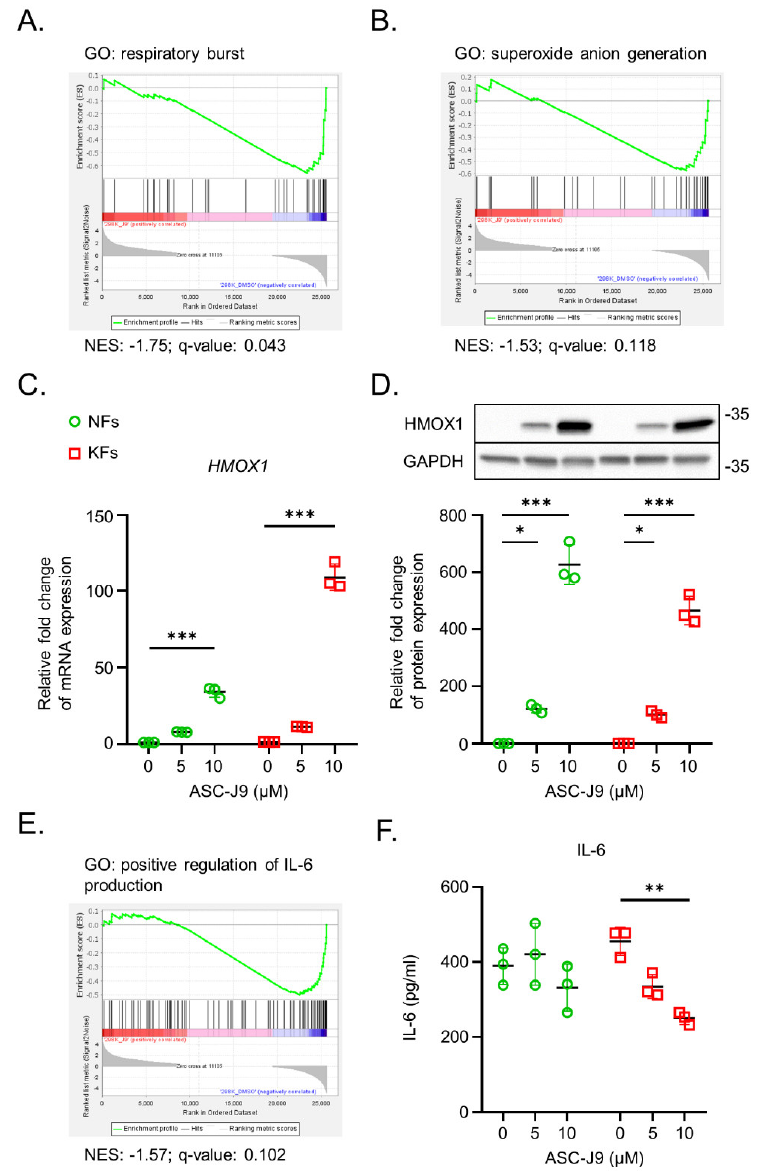
Figure 4. The regulation of ASC-J9 of the oxidative and inflammatory responses of normal fibroblasts and keloid fibroblasts. ( A , B ) The biological pathways related to ROS were analyzed by GSEA. ( C , D ) The mRNA and protein levels of HMOX1 expression in NFs ( n = 3) and KFs ( n = 3) treated with 0, 5, or 10 µ M ASC-J9 for 24 h were detected by qPCR and Western blotting. The relative fold change in mRNA and protein expression in each group was normalized to that in NFs without ASC-J9 treatment. ( E ) The biological processes related to inflammation were indicated by GSEA. ( F ) IL-6 protein of NFs ( n = 3) and KFs ( n = 3) in a conditioned medium after treatment with 0, 5, or 10 µ M of ASC-J9 for 24 h was detected by ELISA. The relative fold change in protein expression of each group was normalized to that in NFs without ASC-J9 treatment. GSEA, gene set enrichment score; ROS, reactive oxygen species; ELISA, enzyme-linked immunosorbent assay; NFs, normal fibroblasts; KFs, keloid fibroblasts. * p < 0.05, ** p < 0.01, *** p < 0.001. p -values were determined by two-way analysis of